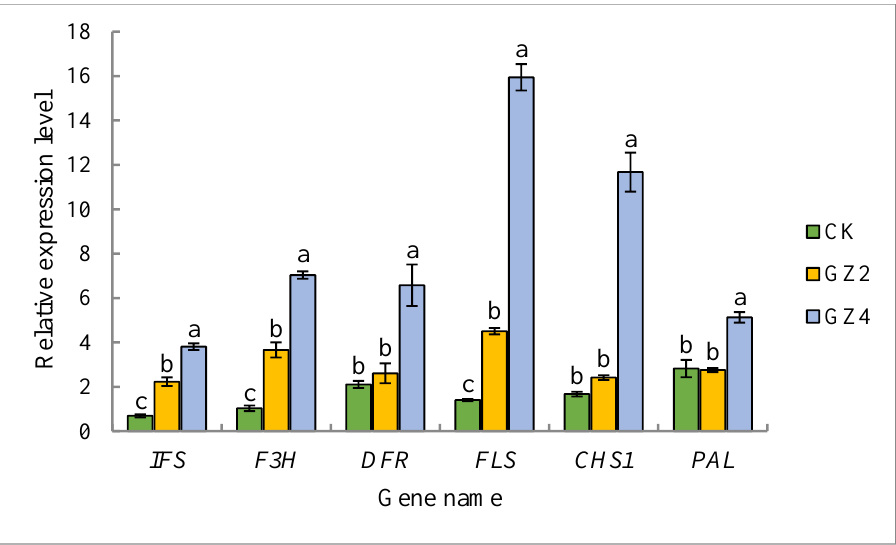
Figure 10. Results of qRT‒PCR analysis of the six genes ( IFS , F3H , DFR , FLS , CHS1 , and PAL ) in the flavonoid biosynthetic pathway of C. drupifera under different concentrations of Al. Different letters indicate statistical significance ( p < 0.05).